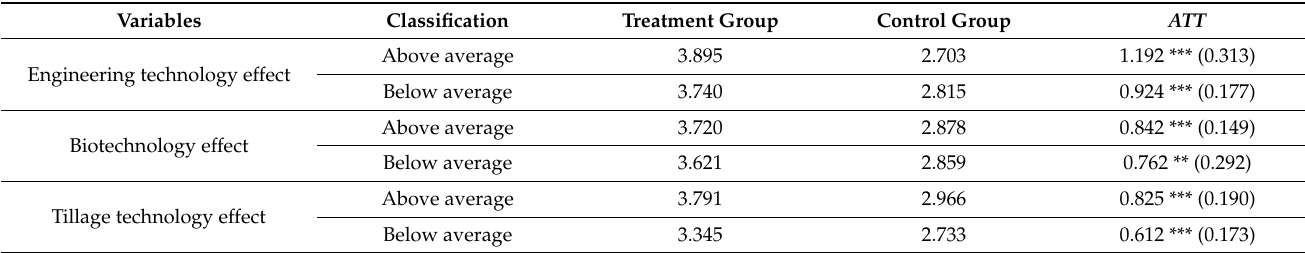
Table 5. Estimates based on technology